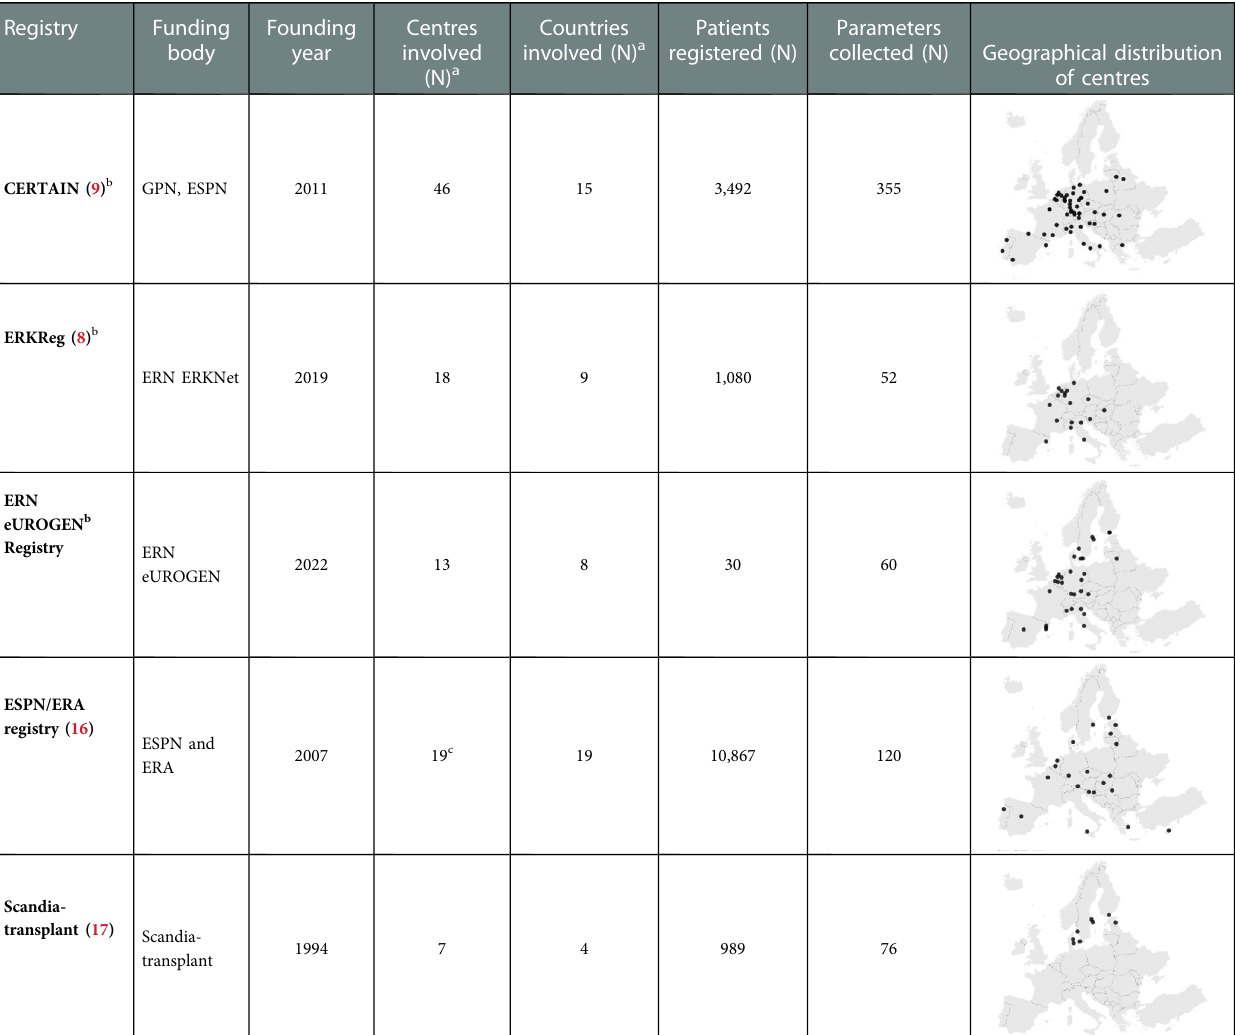
TABLE 1 Overview of European registries on paediatric kidney